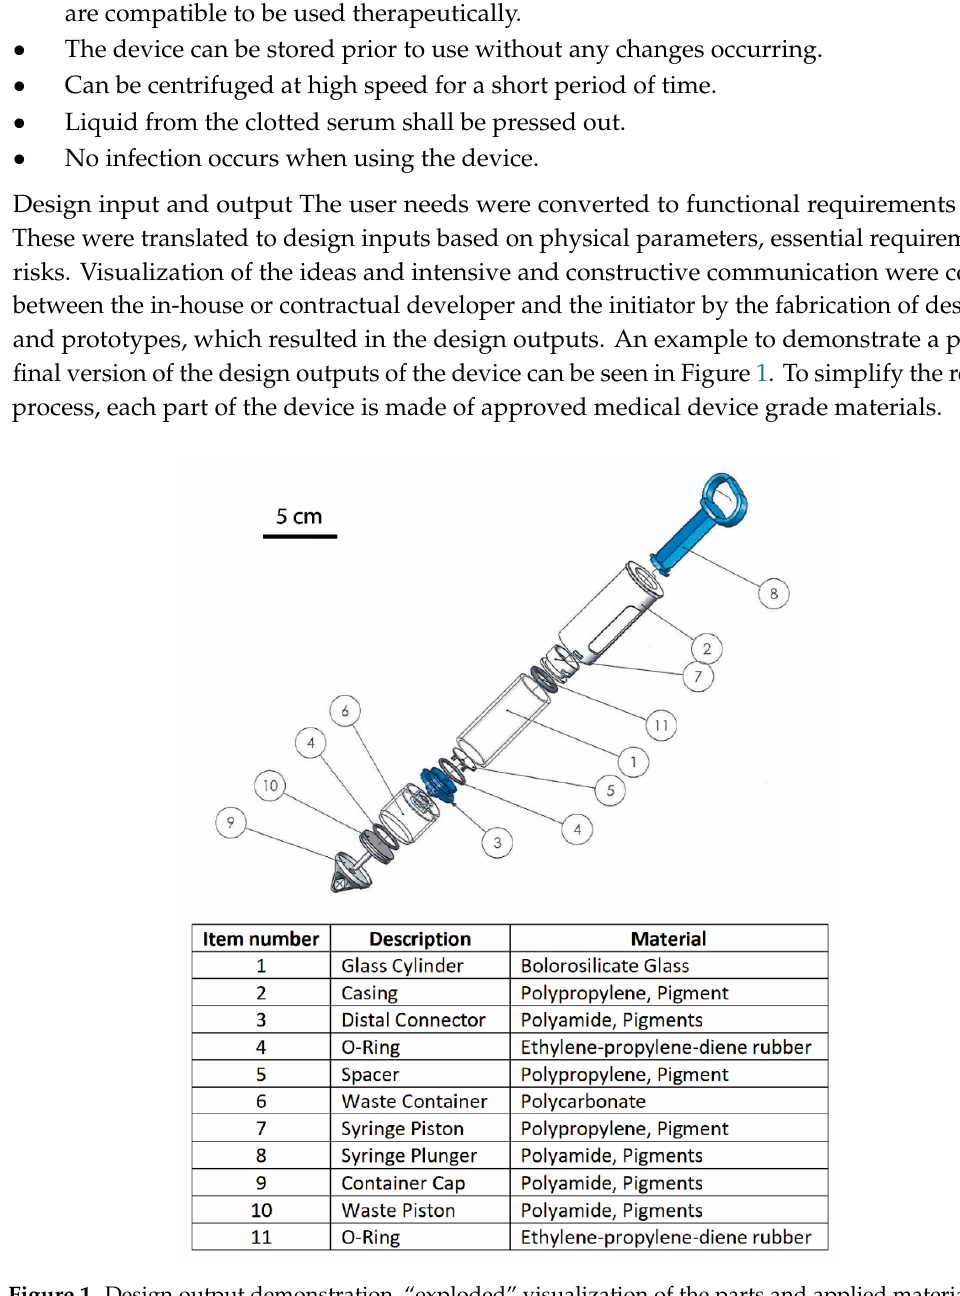
Figure 1. Design output demonstration, “exploded” visualization of the parts and applied materials of the device.